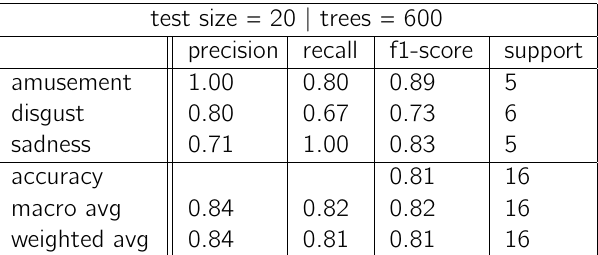
Figure 6: Confusion matrix for the first results produced by the model using the full data set with SMOTE data added.